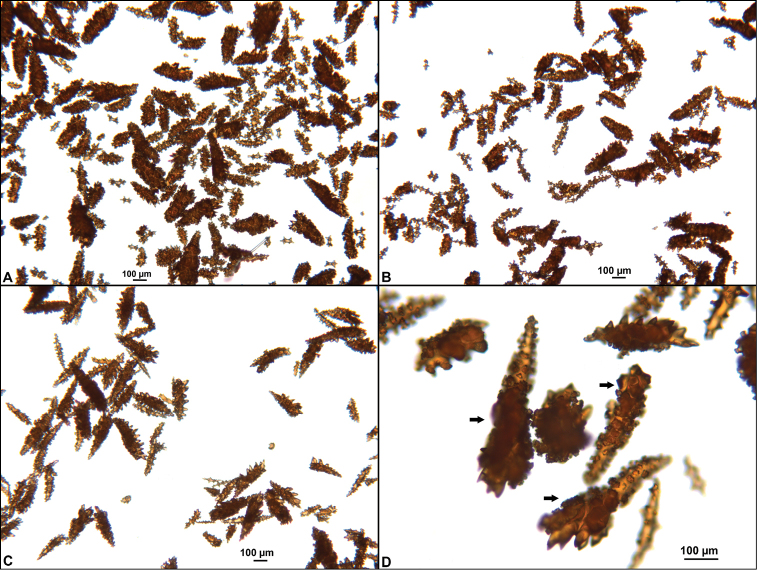
Muriceacalifornica. A–CSBMNH 422911, SBMNH 422914, and SBMNH 422361, respectively; light microscopy arrays, 4× magnification, showing diverse mix of sclerites seen in the species D Light microscopy array, the “torch-like,” multi-toothed sclerites so typical of M.californica, shown at 10× magnification. In D the middle, upside-down torch measures some 580 µm, the middle upright torch measures ~400 µm, while the torch lower down measures 480 µm.